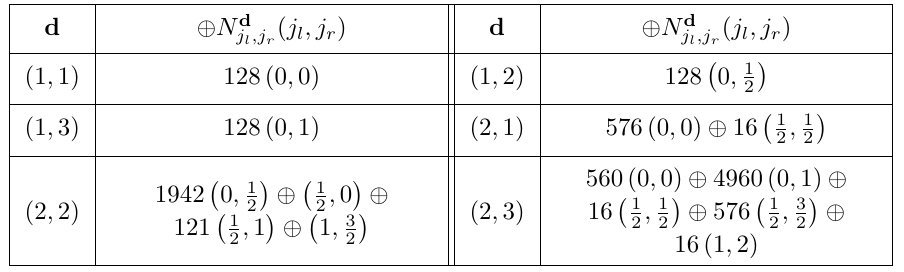
Table 10. BPS spectrum of SU(2) + 8 F theory for d 1 ≤ 2 and d 2 ≤ 3 . Here, d = ( d 1 , d 2 ) labels BPS states with charge d 1 m 0 + d 2 φ . For convenience, we set all flavor mass parameters m i =1 , ··· , 8 to